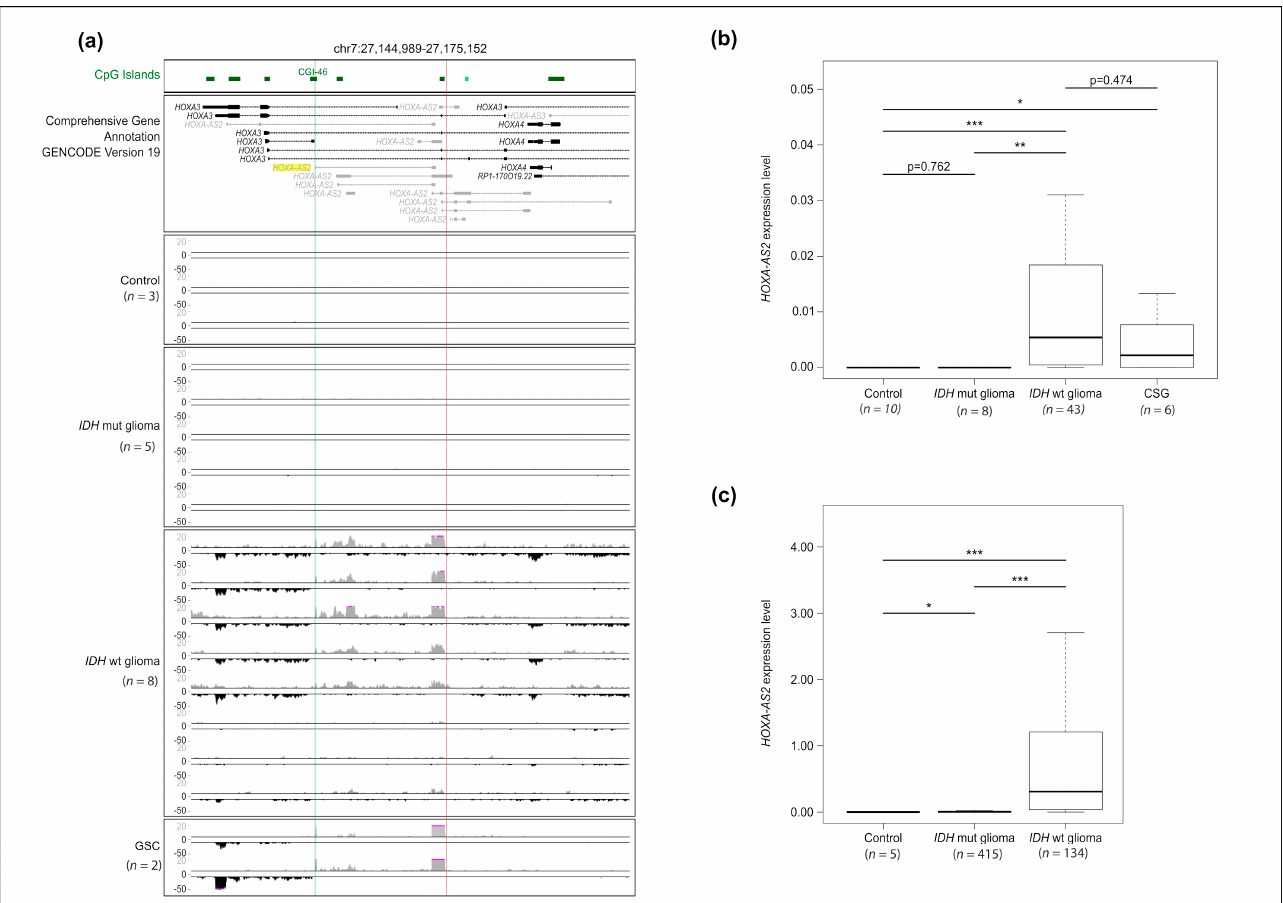
Figure 1. Expression of the HOXA-AS2 transcript in IDHwt glioma samples and GSC lines. ( a ) Strand-oriented RNA-seq signals along the genomic region encompassing HOXA-AS2 isoforms in control ( n = 3), IDHmut ( n = 5) and IDHwt ( n = 8) glioma, and Glioma Stem Cell (GSC) ( n = 2) samples. For each sample, sense (in black) and antisense (in gray) transcription signals are shown in the lower and upper panels, respectively. The positions of 5 ′ and 3 ′ ends, identified using the RACE-PCR ap- proach, in one IDHwt glioma sample are shown by a green and red vertical line, respectively. ( b ) and ( c ) Relative expression level of HOXA-AS2 in control, IDHmut and IDHwt glioma, and GSC samples from our cohort analyzed by microfluidic-based RT-qPCR ( b ) and from the TCGA cohort, analyzed by RNA-seq ( c ). In ( b ), values are the fold change relative to the geometrical mean of the expression of the housekeeping genes PPIA , TBP , and HPRT1. * p < 0.05, ** p < 0.01, *** p < 0.001 (Mann-Whitney U -test).